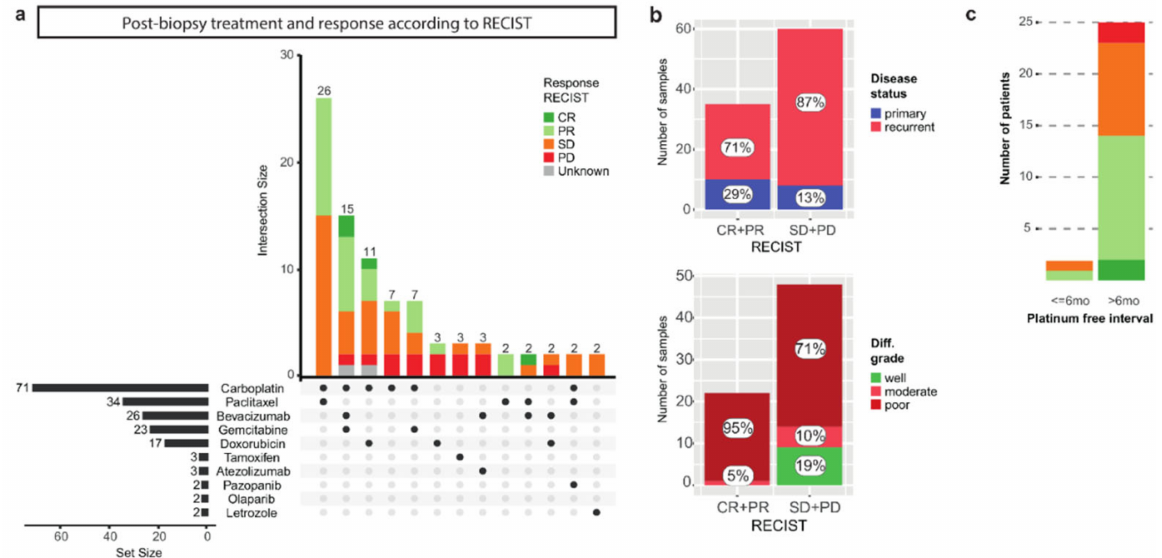
Figure 2. Post-biopsy treatment and RECIST response. ( a ) UpSet plot with post-biopsy treatment. Treatments and treatment combinations given less than twice are cropped from this plot (complete data supplied in Table S1). Horizontal bars (set size) indicate the number of patients that received a single treatment (including all patients that received a unique combination which is cropped from this plot). Vertical stacked bars (intersection size) indicate the number of patients that received a treatment combination and the response to this treatment combination according to RECIST (version 1.1). CR = complete response, PR = partial response, SD = stable disease, PD = progressive disease. ( b ) Favorable RECIST response (CR + PR) and poor RECIST response (SD + PD) assessed for patients with primary versus recurrent disease, and according to the differentiation grade at diagnosis. ( c ) Response to platinum according to RECIST, for patients with a platinum free